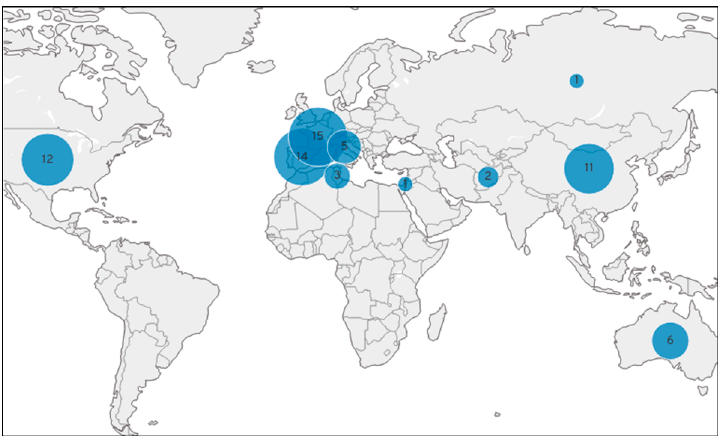
Figure 4. Origins of the resequenced accessions.